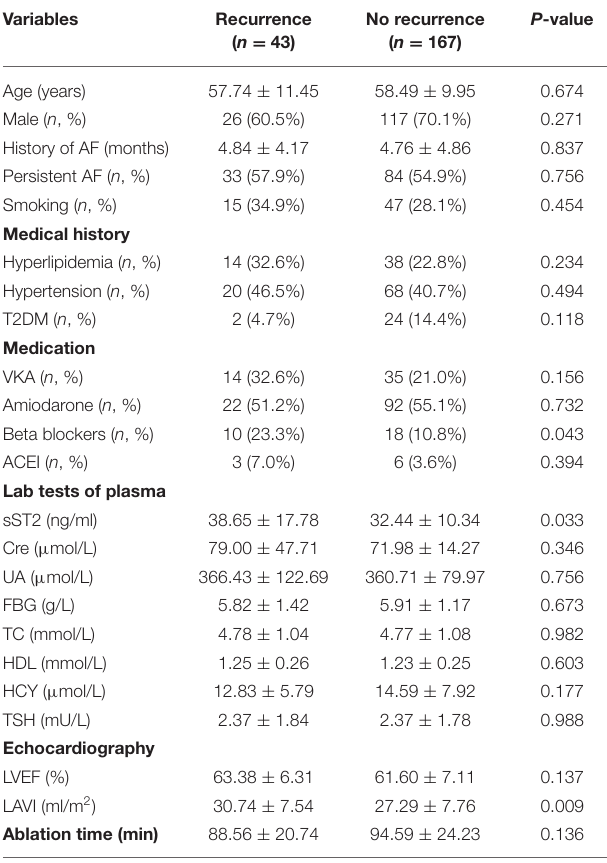
TABLE 1 | Clinical characteristics in all atrial fibrillation (AF) patients.